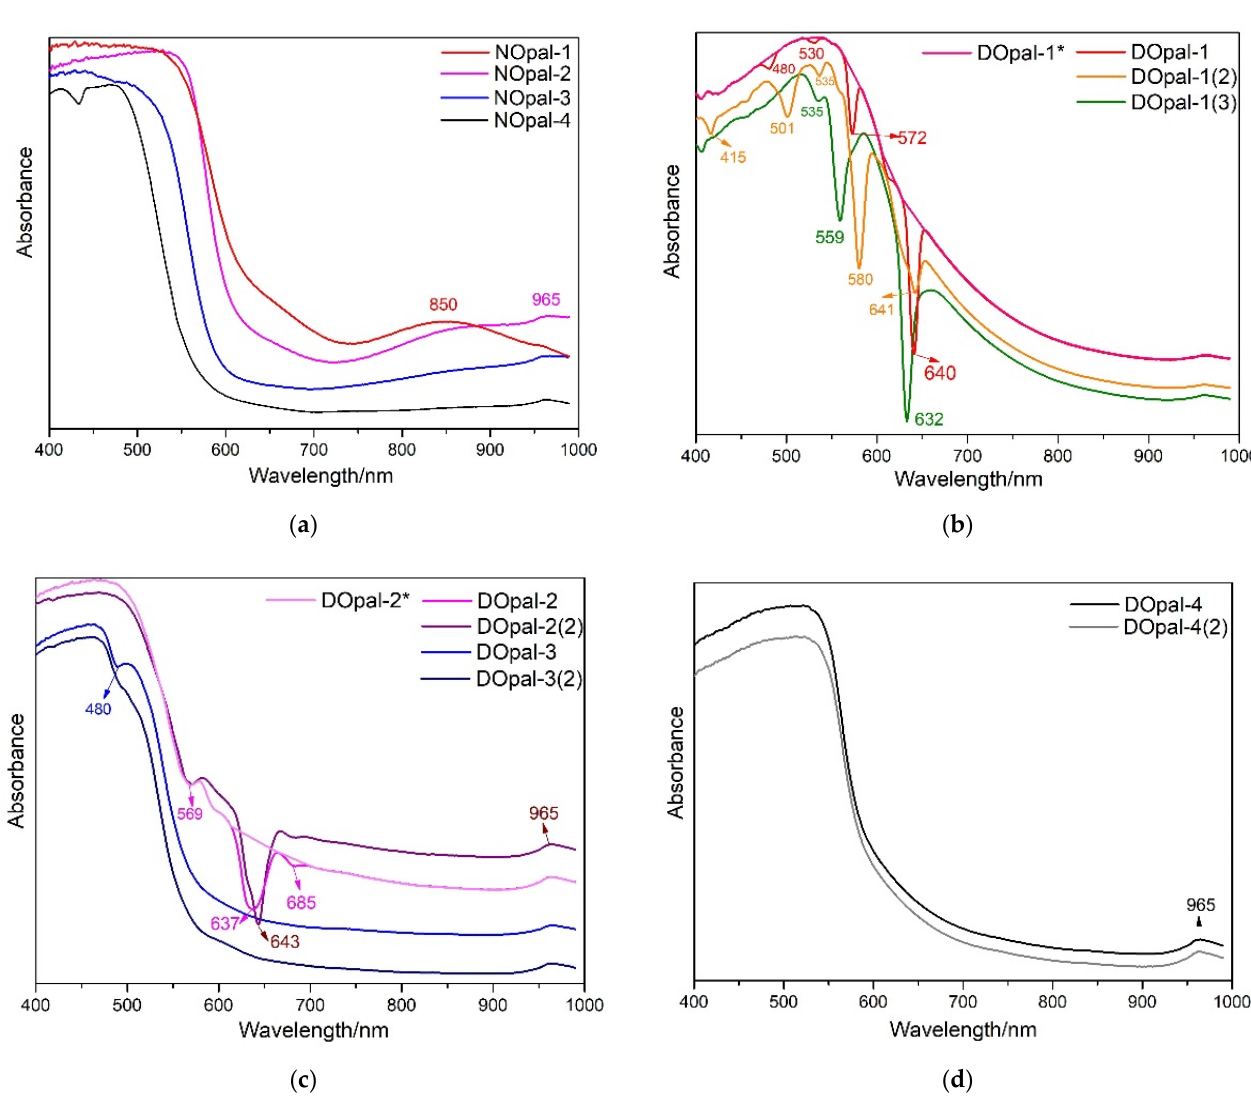
Figure 9. UV-VIS absorption spectra: ( a ) natural opals; ( b – d ) dyed opals. (The spectra DOpal-1* and DOpal-2* are presented using the processed data)